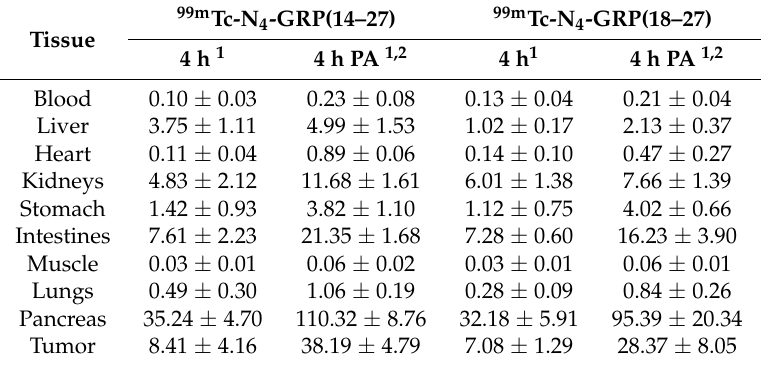
Table 3. Comparative biodistribution data for 99m Tc-N 4 -GRP(14–27) and 99m Tc-N 4 -GRP(18–27), expressed as %ID/g mean ± sd, n = 4, in PC-3 xenograft-bearing SCID mice at 4-h pi (controls) and 4-h pi after coinjection of